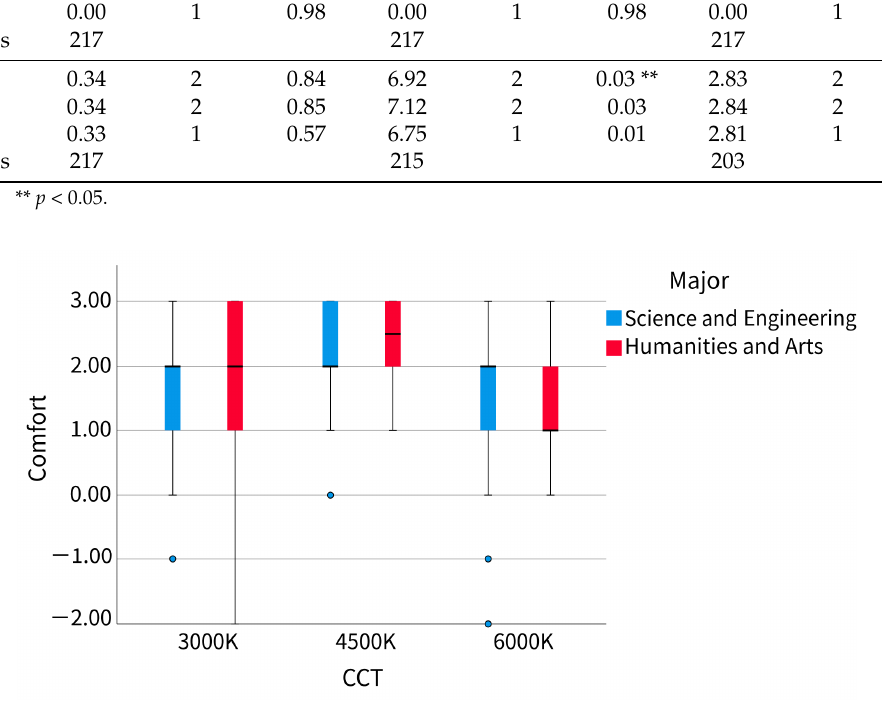
Figure 10. Comfort score boxplot (major).